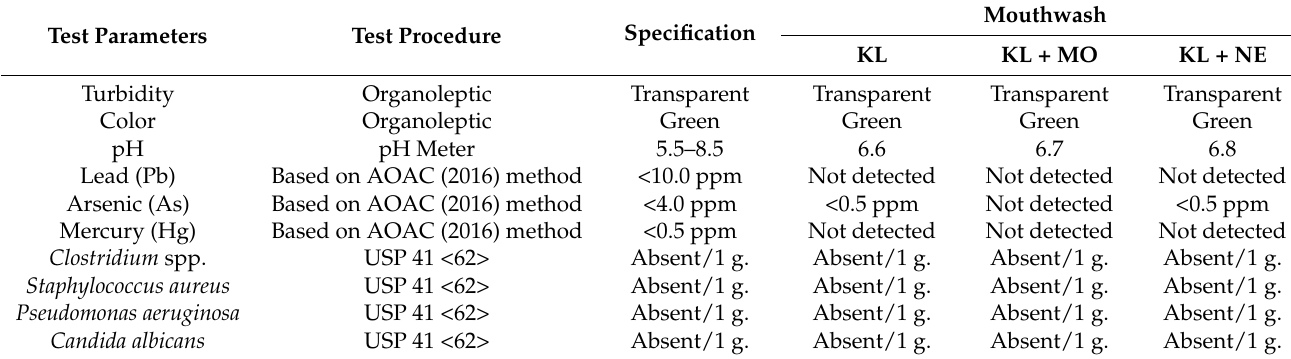
Figure 2. Chromatogram from GC-MS analysis. C. hystrix DC. ( a ), Moringa oleifera Lam. ( b ) and Azadirachta indica A. Juss. ( c ). Table 1. Chemical constituents identified by GC-MS from C. hystrix , M. oleifera and A. indica ethanolic extracts. Table 2. The results of quality control testing of formulated